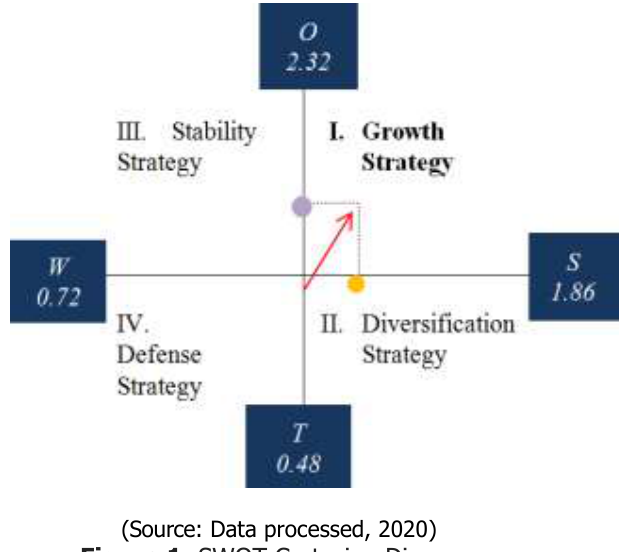
Figure 1. SWOT Cartesian